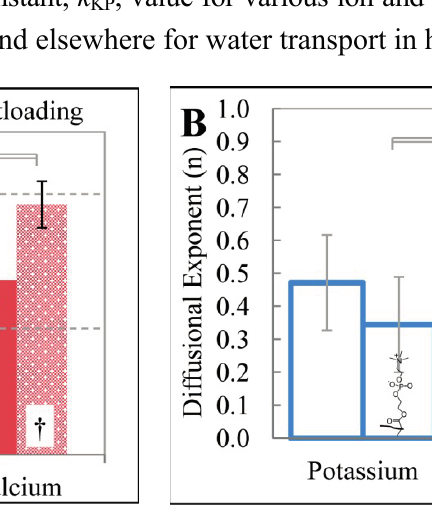
Figure 3. ( A ) Composite diffusional exponent, n , values for different ion and loading. Where * indicates statistical significance ( p < 0.05), ‡ indicates not statistically different than Fickian value of n (0.43) and † indicates not statistically different than Case II value of n (0.89); ( B ) Diffusional exponent values for hydrogels which do not (empty) and do (filled) contain , value for various ion and loading. Shaded MPC; and ( C ) Composite rate constant, k KP